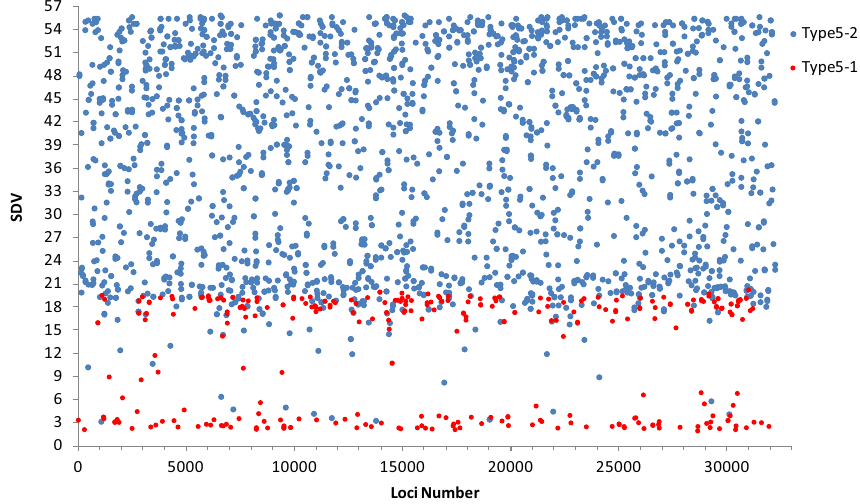
Figure 3. SDVs of type 5 markers with (Type 5-2) and without (Type 5-1) wild-type elimination. 5-1 is represented by red dots and 5-2 by blue dots. The ordinate value refers to segregation distortion values (SDVs) of these markers. The 5-2 markers show higher SDV than those 5-1 markers which have experienced very little wild type elimination.